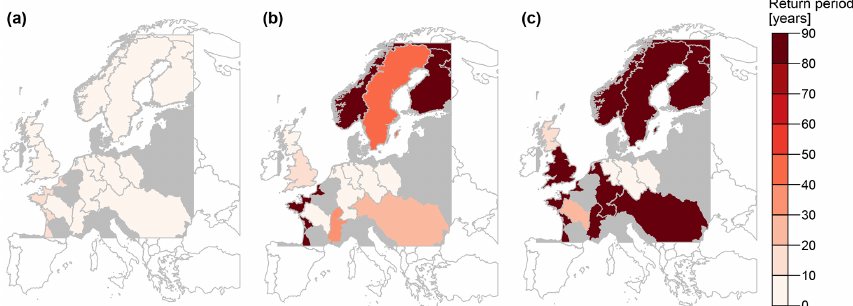
Figure 12. Probabilities of regional flooding for European river basins with more than five catchments, with (a) 30% affected, (b) 50% affected, and (c) 70% affected. Regions with less than five catchments where regional flood probabilities could not be determined are highlighted in grey, and regions not covered by our data set are displayed in